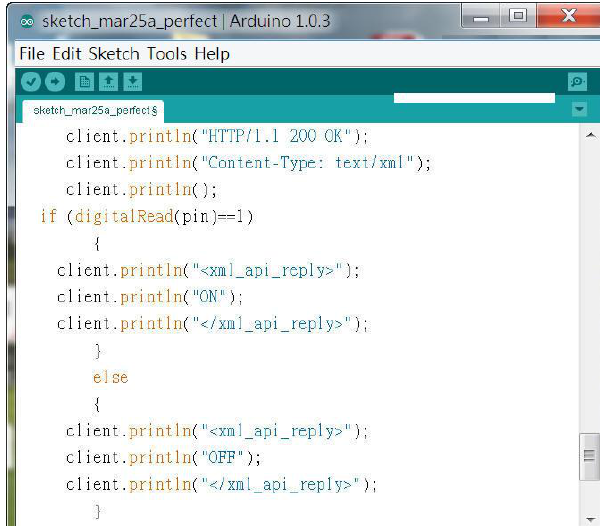
Figure 36. An XML-formatted Web page in C++ codes.